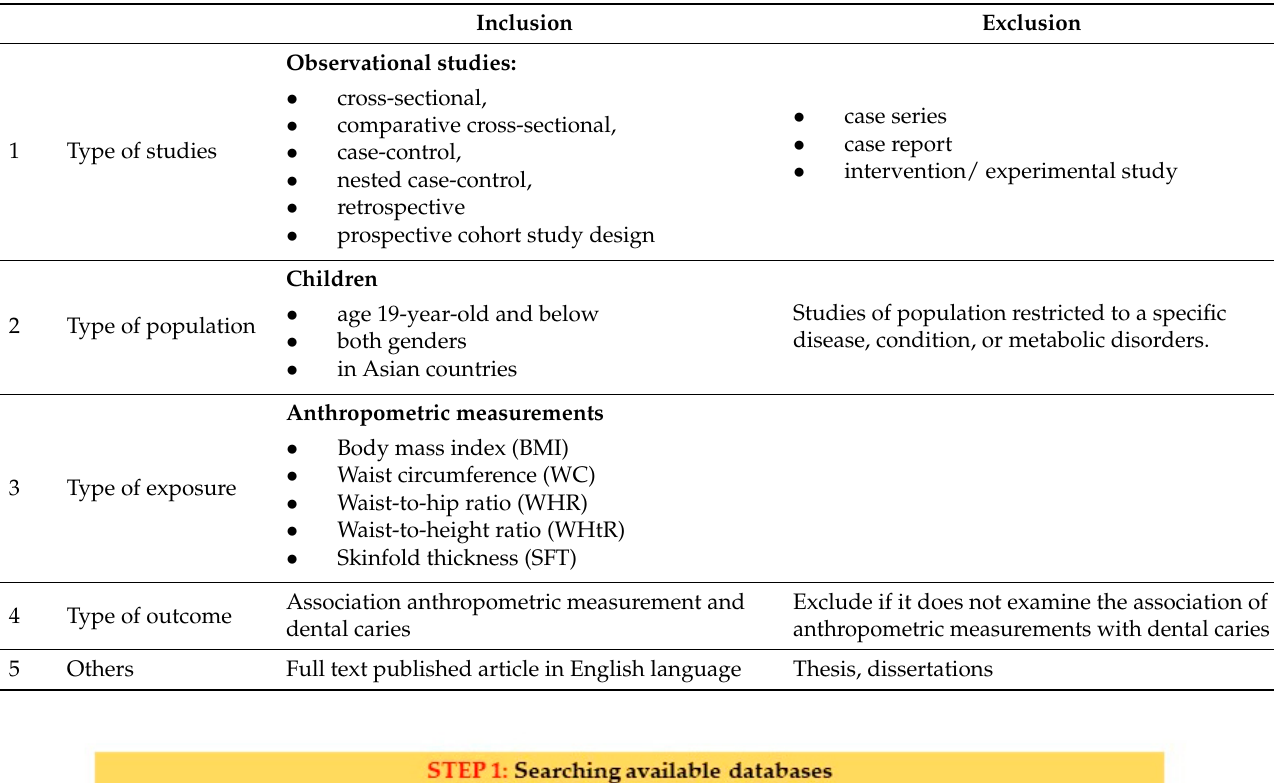
Table 2. Eligibility criteria of the present review.